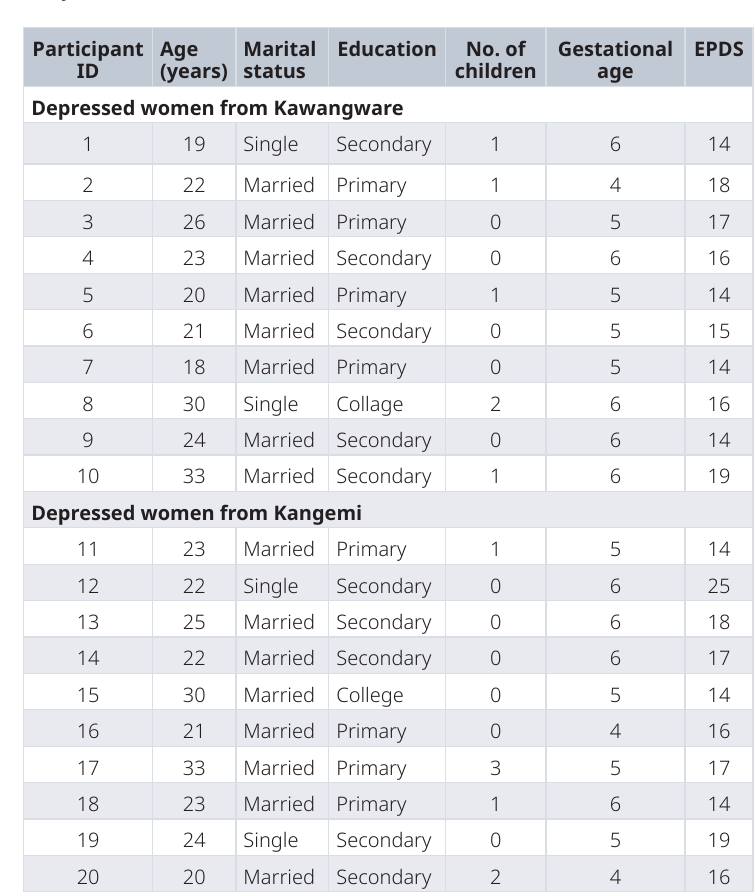
Table 3. Characteristics of the participants in focus group discussions among pregnant women in urban low-income settlements in Nairobi,